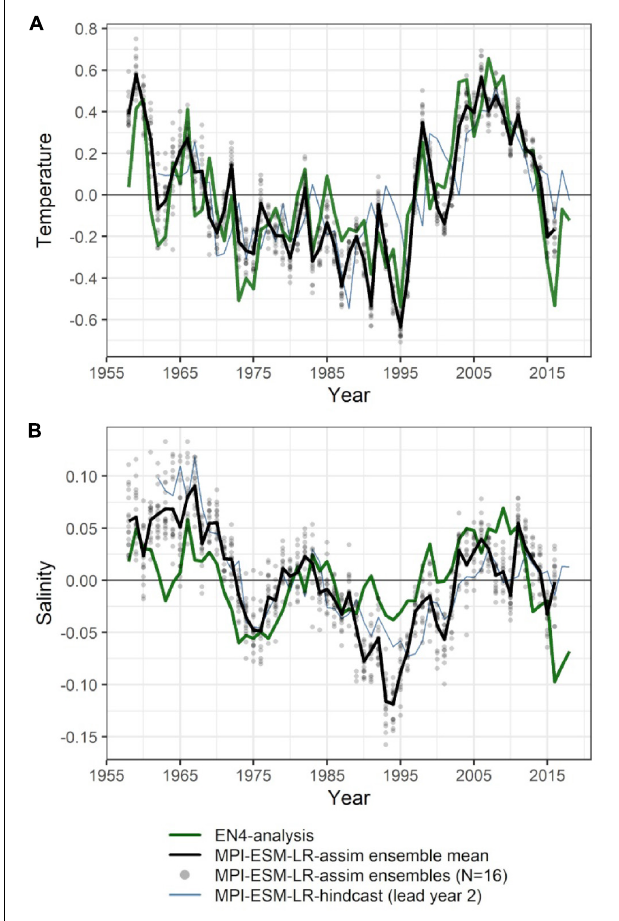
FIGURE 3 | Mean FMA temperature (A) and salinity (B) anomalies averaged over the spawning depth of blue whiting (250–600 m) within the spawning region (black rectangle in Figure 1 ). Data from EN4-analysis is indicated by the green line. The ensemble mean of the assimilation run of MPI-ESM ( MPI-ESM-assim ) is indicated by the black line and its individual ensembles are shown as grey dots, where overlapping ensembles create darker shades. MPI-ESM-hindcast of lead year 2 is added as blue